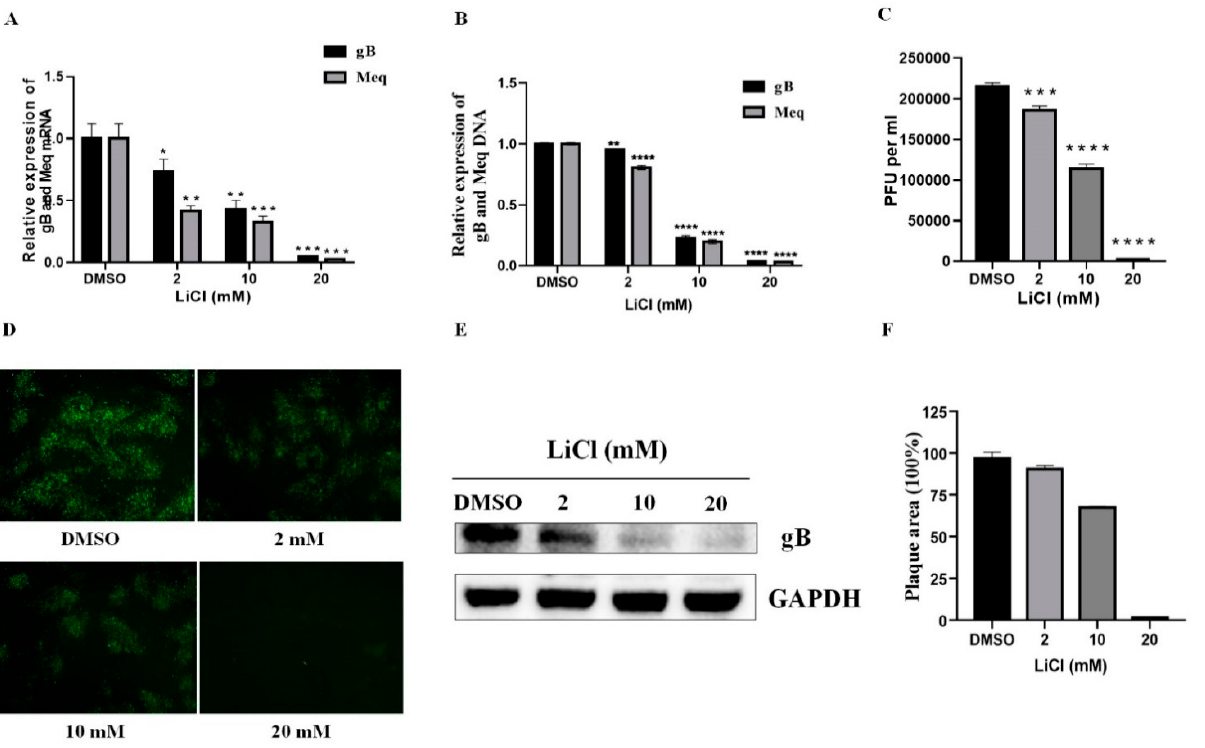
Figure 1. LiCl inhibits the replication of MDV in CEF. Detection of transcript level of gB and Meq genes ( A ) by qRT-PCR and MDV DNA quantity by qPCR ( B ) in CEF infected with MDV RB-1B strain after 96 h treatment with 0, 2, 10, and 20 mM LiCl. ( C ) Plaque count results of MDV RB-1B infected CEF treated with 0, 2, 10, and 20 mM LiCl. ( D ) Determination of the inhibitory effect of LiCl on MDV RB-1B plaque formation in CEF by indirect immunofluorescence assay. The pictures were captured with an OLYMPUS microscope (×200). ( E ) Detection of gB protein expression after treatment with 0, 2, 10,